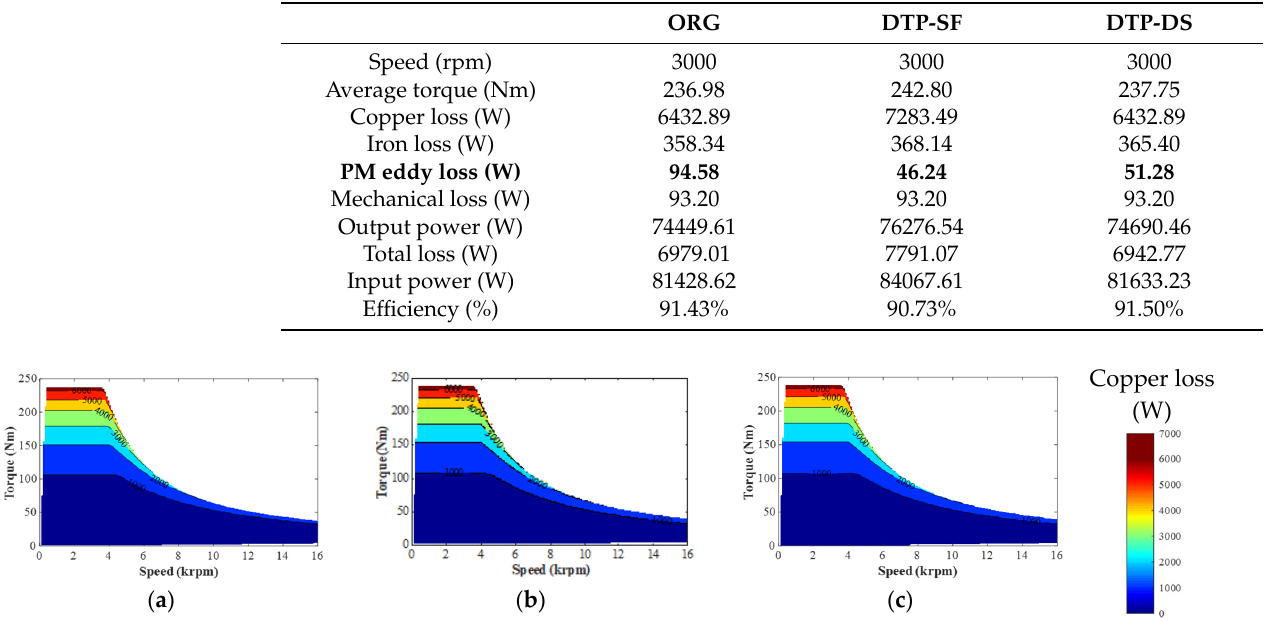
Table 8. Loss and efficiency of different winding configurations under maximum torque condition.